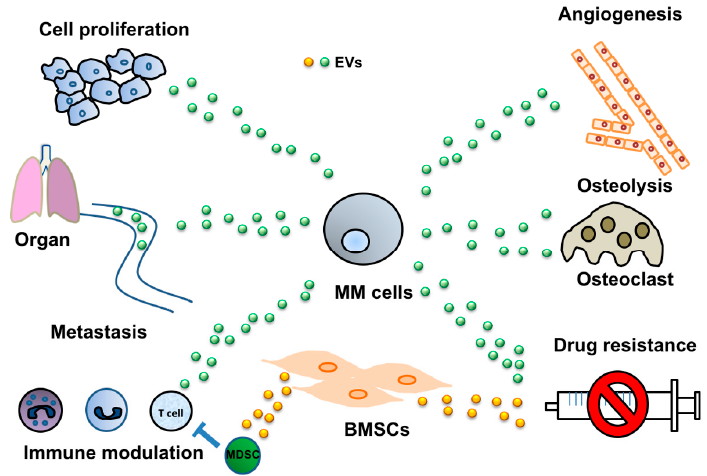
Figure 1. Influence of extracellular vesicles (EVs) on the multiple myeloma (MM) microenvironment. EVs are associated with various alterations in the MM microenvironment including angiogenesis, activation of osteolysis, immune system modulation, and induction of drug resistance. MM cells alter the surrounding microenvironment via EVs for their survival.